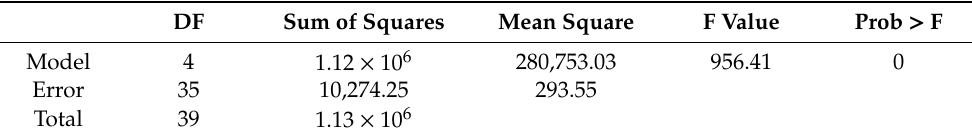
Table 12. ANOVA for multiple regression of variable Yarn